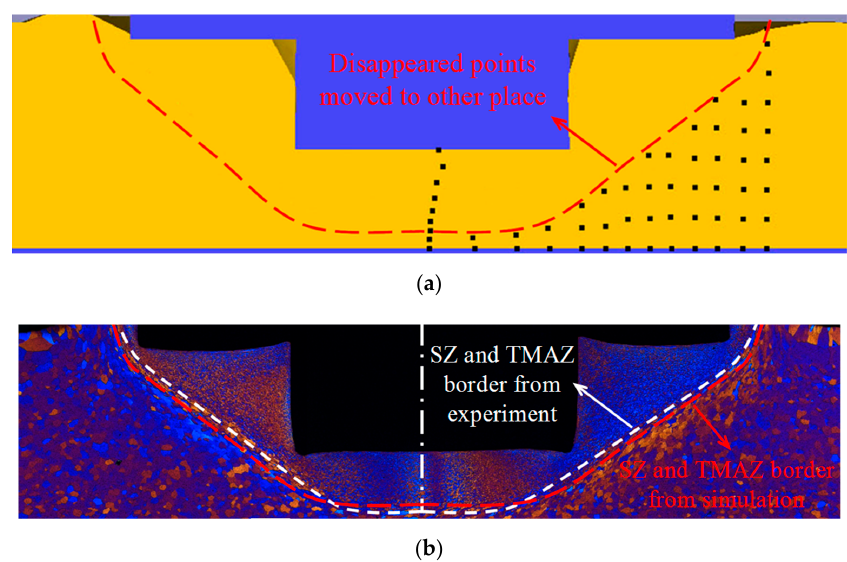
Figure 16. Shape of the stir zone: ( a ) simulation result; ( b ) comparison between the simulation and experiment result. (FSSW parameters: rotating speed 1600 rpm, plunge rate 72 mm/min, plunge depth 2.2 mm, and dwell time 3 s).